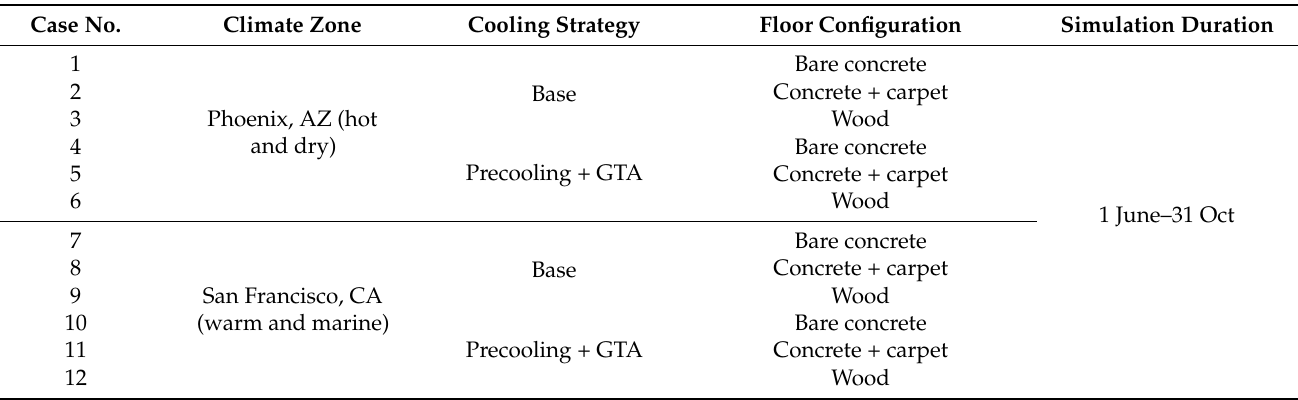
Table 4. Summary of simulated cases.